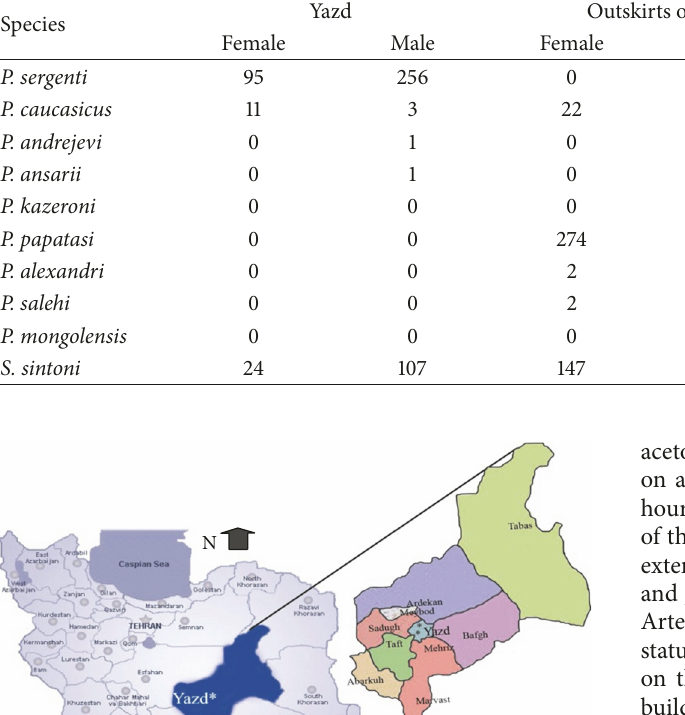
Table 1: Distribution of Phlebotomus and Sergentomyia species in Yazd city and the outskirts of Yazd, 2015. Species